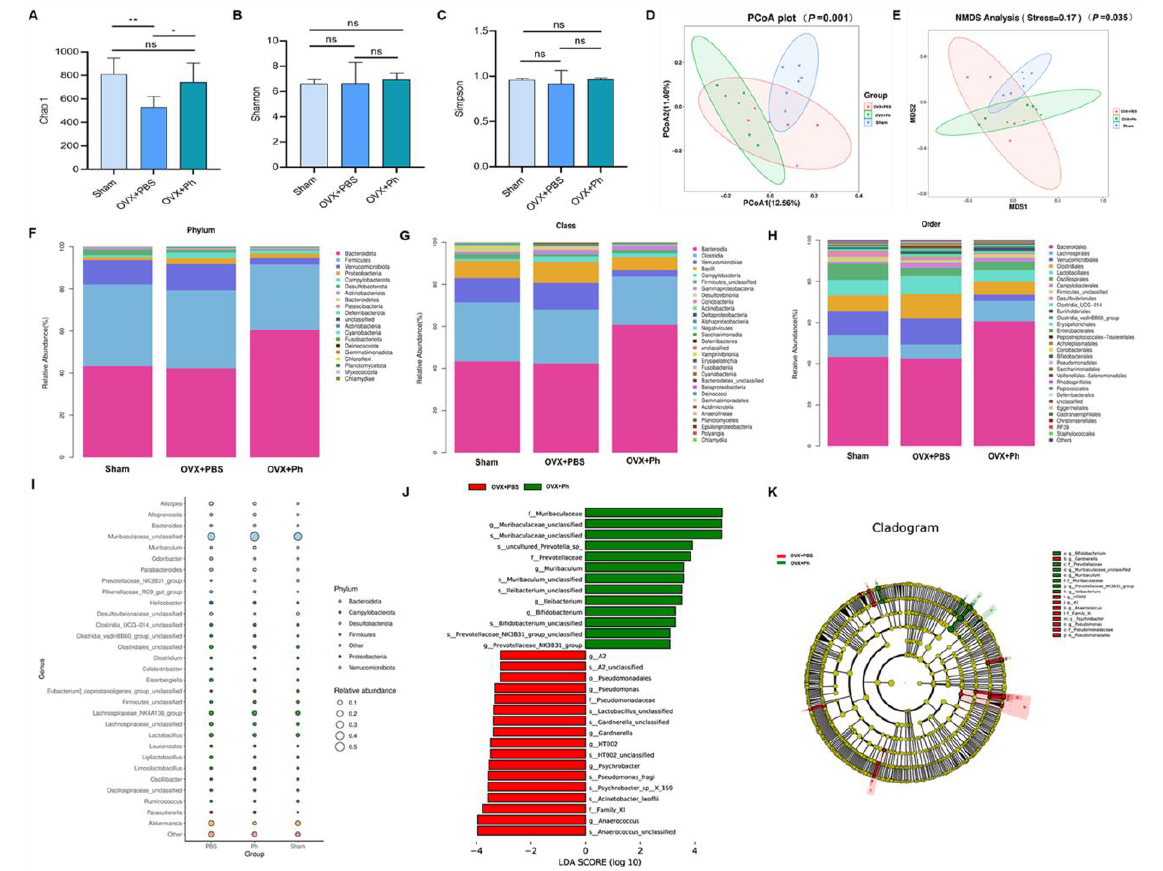
Figure 7. The perfusion of Ph ameliorated the disturbance of GM in mice with OVX-mediated OP. ( A ) Chao 1 index; ( B ) Shannon index; ( C ) Simpson index; ( D ) PCoA plots; ( E ) NMDS analysis plots; ( F ) The composition of GM at phylum level; ( G ) The composition of GM at class level; ( H ) The composition of GM at order level; ( I ) Bubble plots; ( J ) Histogram of LDA value distribution; ( K ) Cladogram. * p < 0.05 and ** p < 0.01 compared with comparable group; ns no significance.